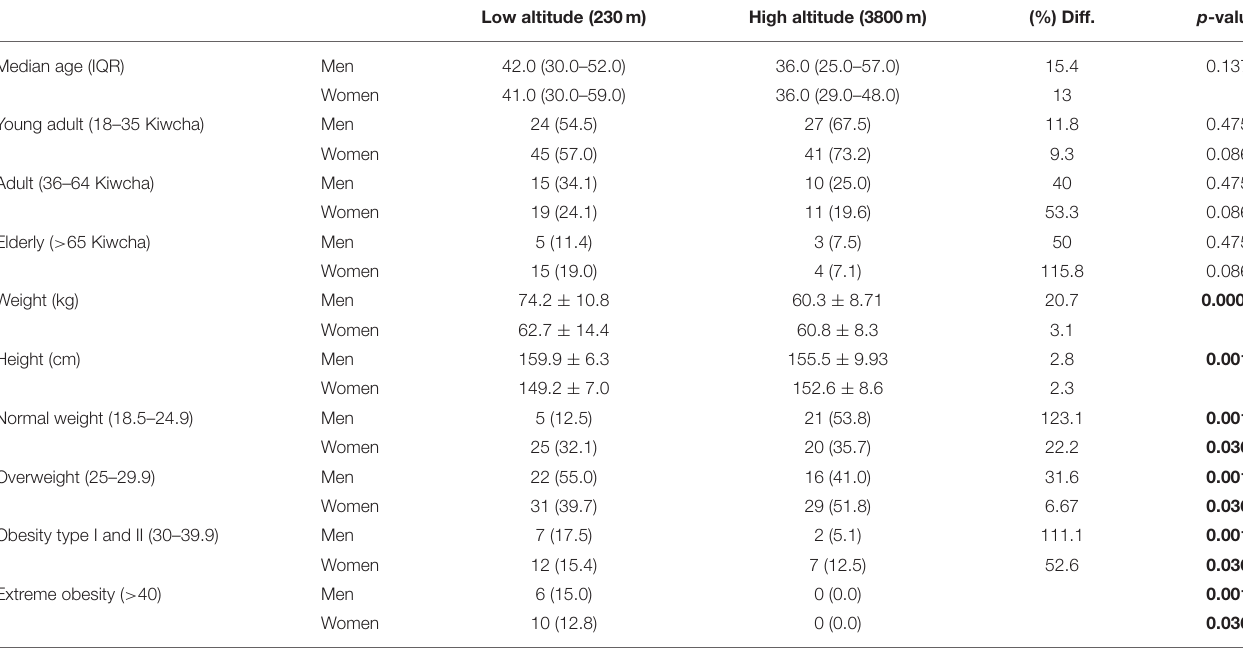
TABLE 1 | Demographic characteristics, weight, height, and body mass index (BMI) of the two populations in relation to sex. Low altitude (230m)